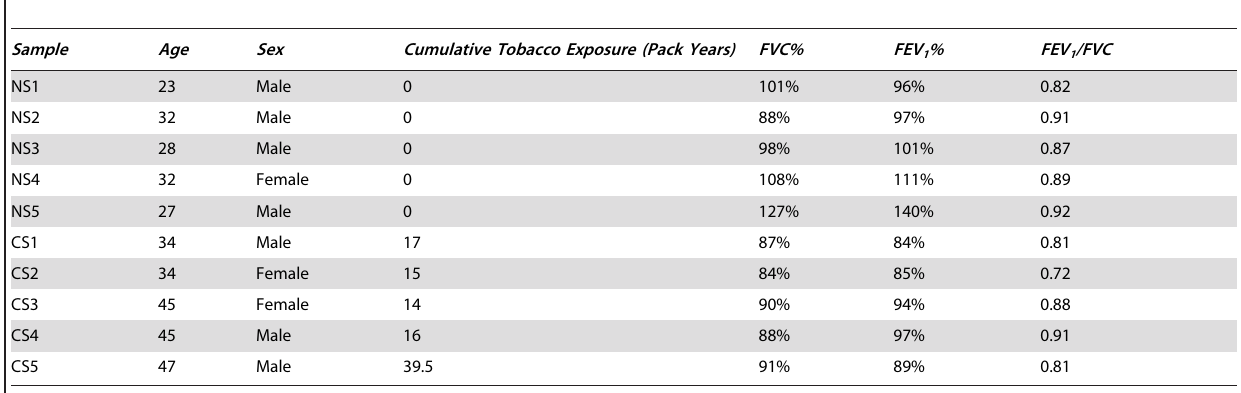
Table 1. Demographics of the 10 subjects undergoing